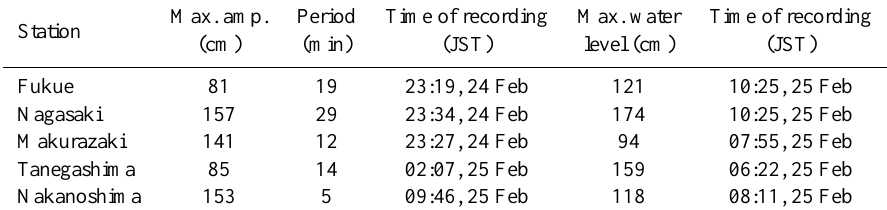
Table 1. Record of secondary oscillations observed in western Japan, reported by the Nagasaki, Marine Observatory et al. (2009). Station